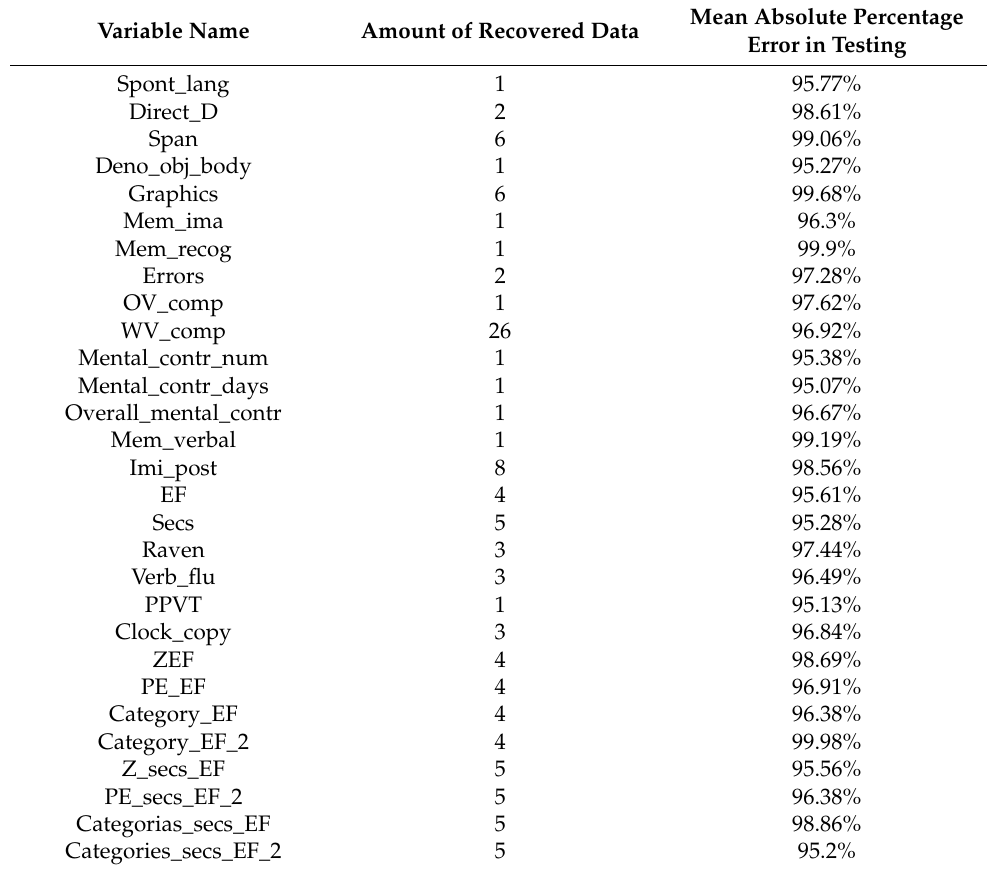
Table 4. Mean absolute percentage error, MAPE, obtained for the recovery of missing data with the test dataset.